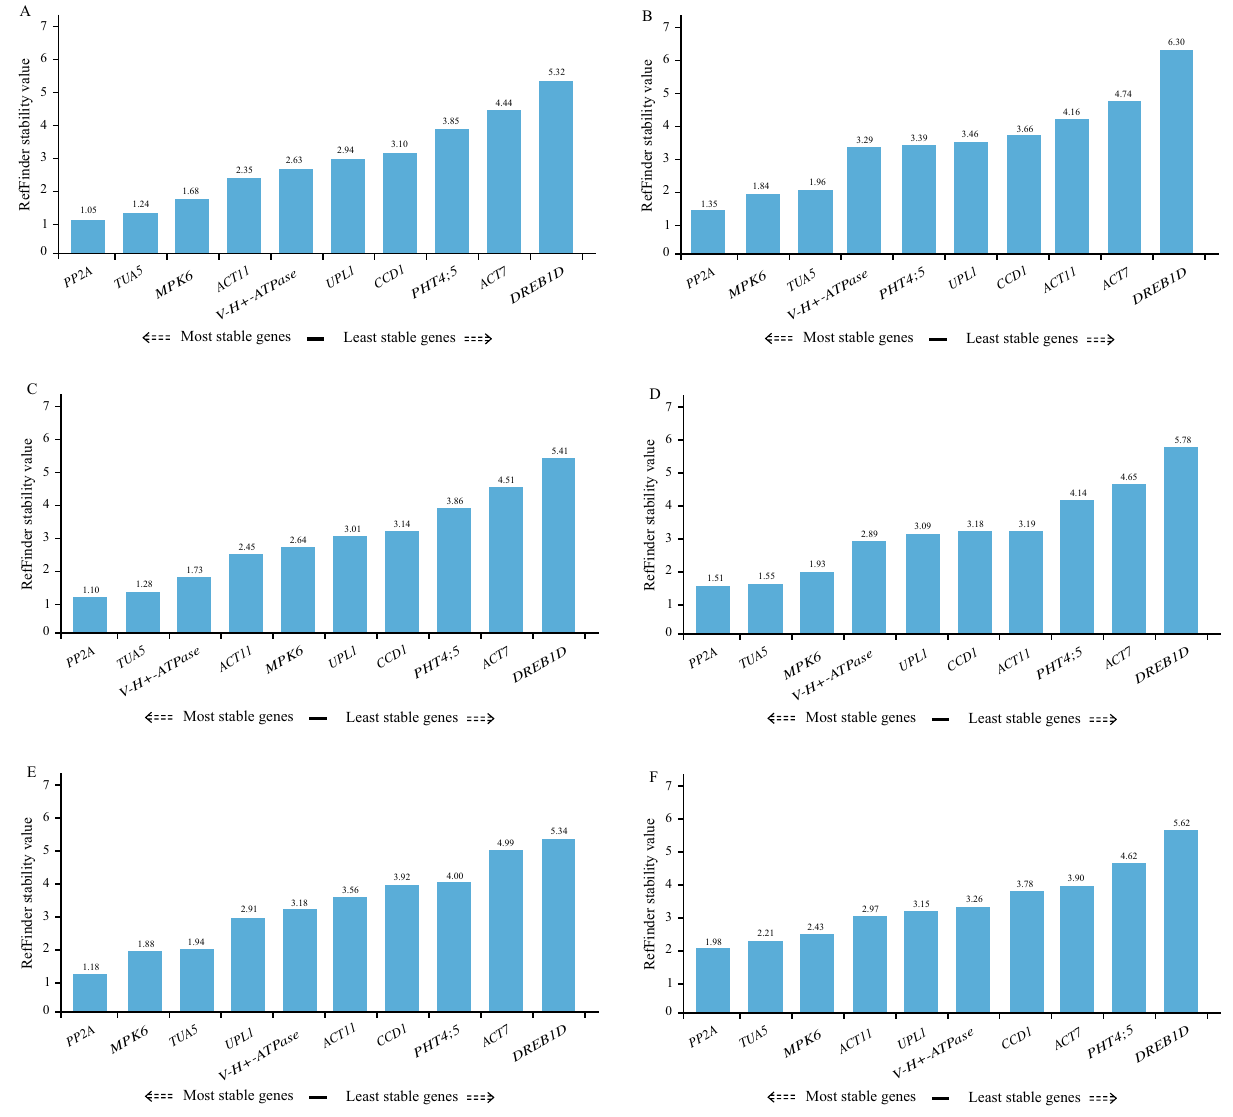
Figure 4. Expression stability of candidate genes in different tissues of S. glauca response to salinity validated by RefFinder program. ( A ) Thirteen tissue samples derived from 1/10 MS liquid medium treatment. ( B ) Thirteen tissue samples derived from 100 mM NaCl treatment. ( C ) Thirteen tissue samples derived from 300 mM NaCl treatment. ( D ) Fifteen germinating seed samples derived from NaCl gradient treatment. ( E ) Eighteen seedling samples derived from NaCl gradient treatment. ( F ) All 72 samples used in this